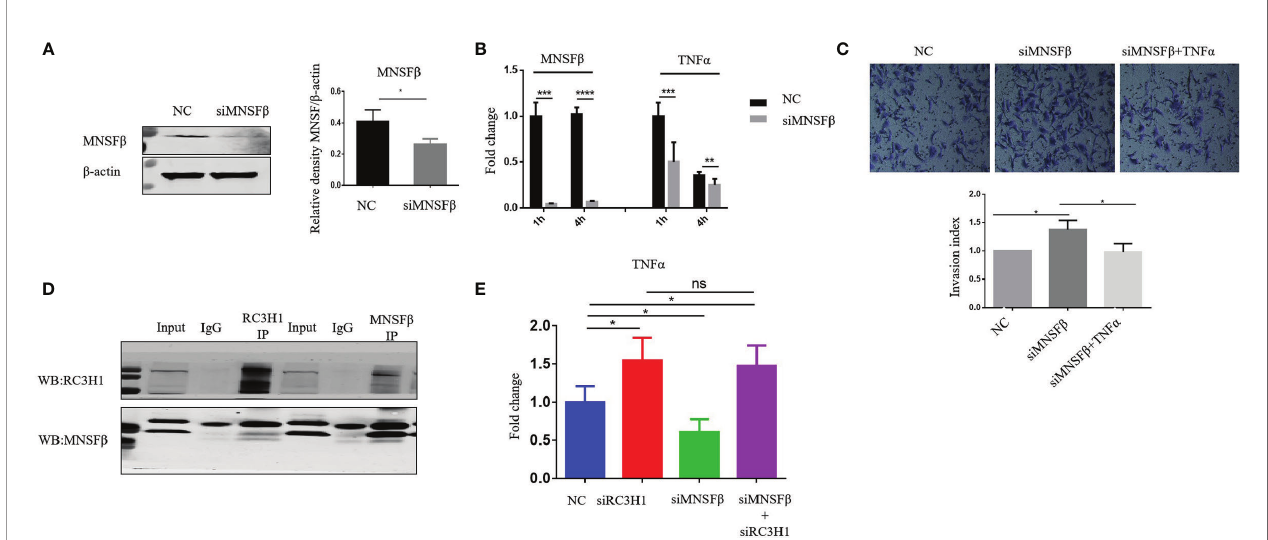
FIGURE 5 | MNSF b promoted the expression and secretion of TNF a by binding to RC3H1 in human macrophages. (A) MNSF b protein expression level in human Thp1-derived M f as detected by Western blotting analysis (normalized to the expression of b -actin). Left panel: representative images of Western blotting assay. Right panel: the relative density of MNSF b / b -actin. (B) MNSF b and TNF a mRNA expression levels in Thp1-derived M f as detected by RT-PCR analysis (normalized to the mRNA expression of Gapdh). (C) Invasive activity of HTR8/SVneo cells detected by transwell assay. Upper: representative images of the Transwell assay; lower: quanti fi cation of the Transwell assay by the invasion index [invasion index = X (invaded cells number)/NC (invaded cells number)]. (D) Interaction between MNSF b and RC3H1 as validated by co-IP assay. (E) TNF a mRNA expression level in Thp1-derived M f detected by RT-PCR analysis (normalized to the mRNA expression of Gapdh). (NC: Thp1-derived M f transfected with NC-siRNA or HTR8/SVneo cells treated with the CM of NC M f ; siMNSF b : Thp1-derived M f transfected with MNSF b -speci fi c siRNA or HTR8/SVneo cells treated with the CM of siMNSF b M f ; siMNSF b + TNF a : HTR8/SVneo cells treated with the CM of